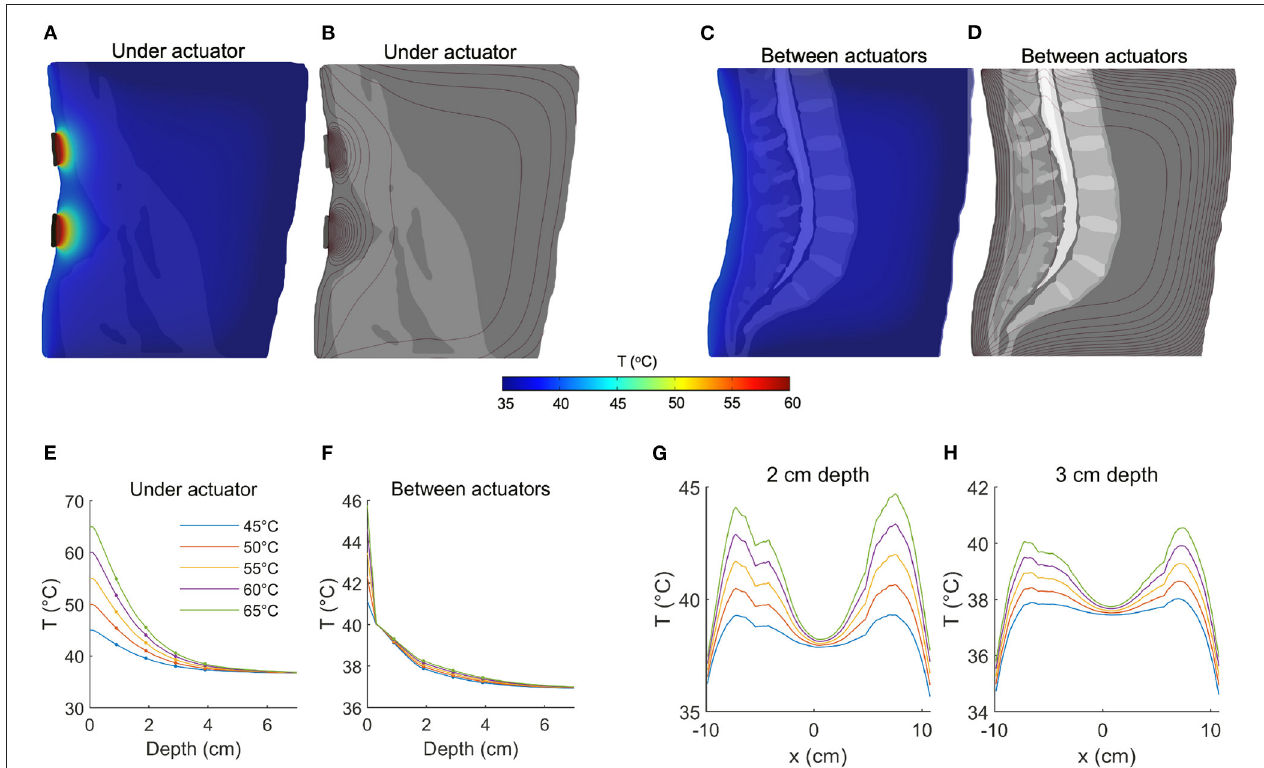
FIGURE 2 | Quantifying temperature increases during thermal massage. (A) Temperature of a sagittal slice of the volume during thermal massage with the actuators set to 65 ◦ C. The selected slice was located directly anterior to the actuators. The resulting temperature decayed exponentially with distance from the heating elements. (B) The contours of the temperature distribution shown in (A) . (C) Temperature of a sagittal slice located between actuators. The resulting temperature increase was markedly lower. (D) Contours corresponding to the temperature distribution in (C) . (E) The temperature directly anterior to an actuator as a function of depth, shown for five different actuator temperatures. At a depth of 2 cm, temperature increased by 3–8 ◦ C. The temperature increase at 3 cm depth was between 1 and 3 ◦ C. (F) Between actuators, the achieved temperature increase was greatly dampened, with an increase of only 1 ◦ C at a depth of 2 cm. (G) The tissue temperature distribution from left to right, shown for a fixed depth of 2 cm. The proximity of the tissue to the actuator placement determines the level of heating (actuators are positioned at ± 6 cm). (H) Same as (G) but now for a depth of 3 cm, showing the increment in deep tissue temperature for different actuator